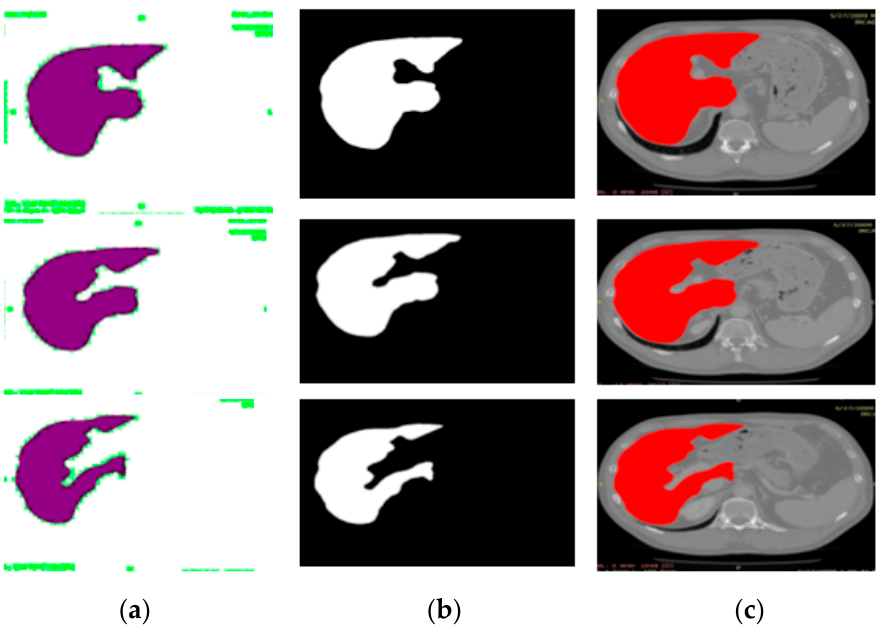
Figure 5. Depiction of the results of segmentation, demonstrating that the suggested model accurately detects the liver. ( a ) Original images ( b ) binary segmentation ( c ) mapped segmented region on the original images.